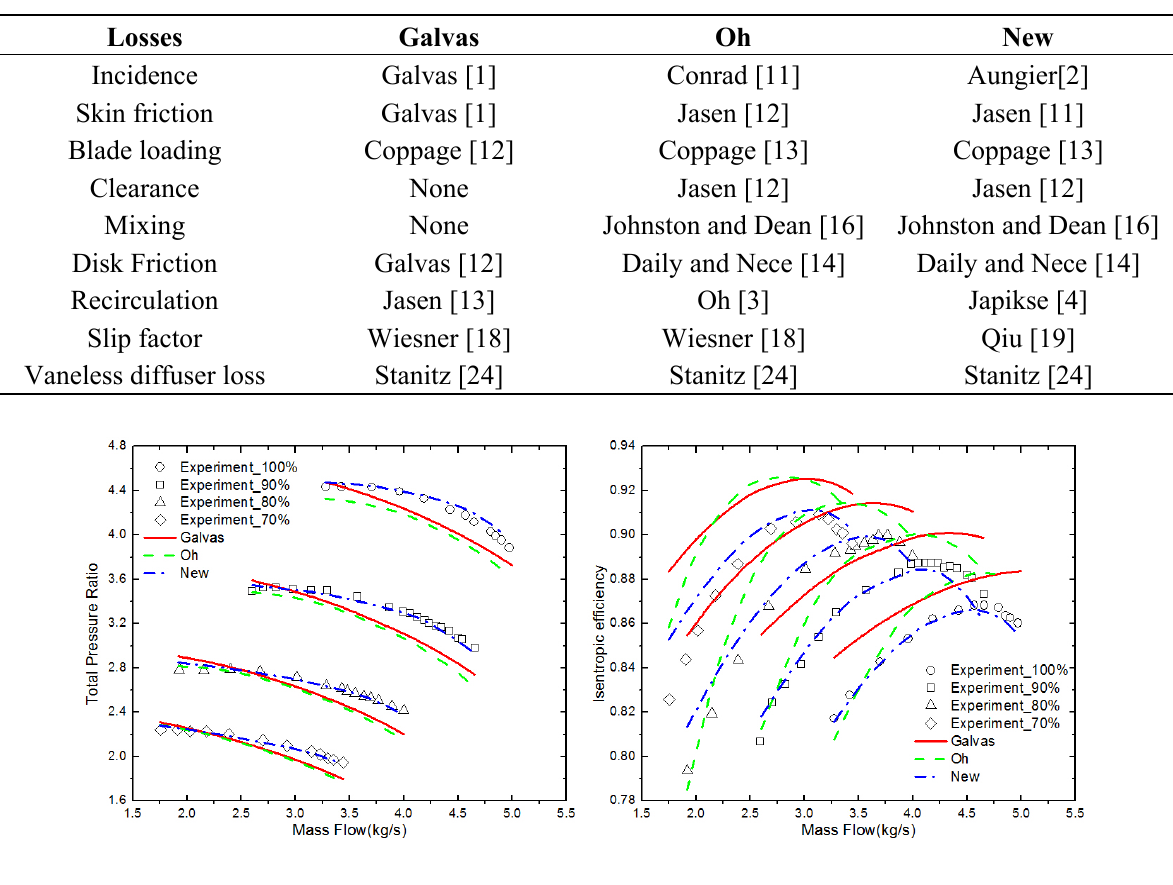
Figure 1. Performance prediction of HPCC impeller with a vaneless